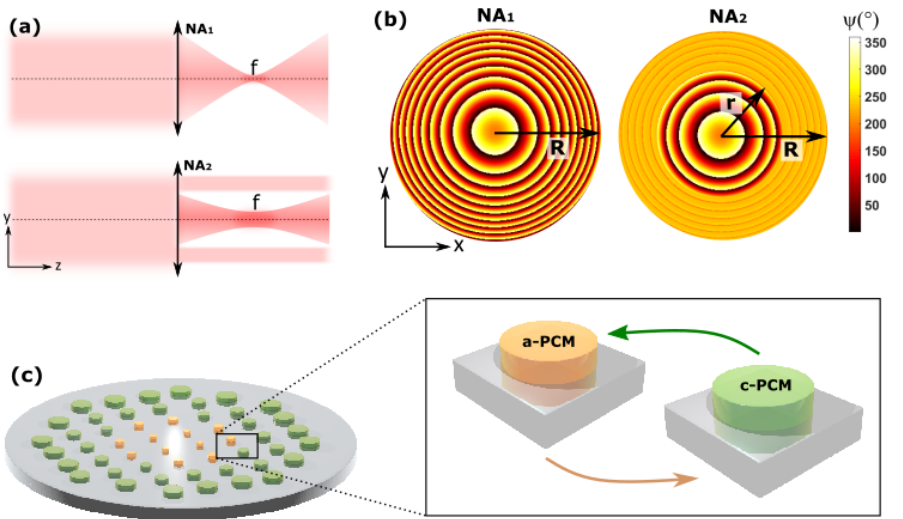
Figure 1. ( a ) Effect of NA switch on an incident beam, with the larger NA value above and the smaller below. The reduction in NA is accompanied by a broadening of the focal spot. Note that our device operates in reflection, but this illustration is shown in transmission for clarity. ( b ) Illustrative phase profile of device in larger NA state on left (whole device of radius R with parabolic phase profile) and smaller on right (inner region of radius r with parabolic phase profile and outer region with near-flat phase profile). ( c ) Schematic illustration of device with the inner region shown in yellow and the outer in green. The switch is effected by changing the material phase of the outer region phase-change materials